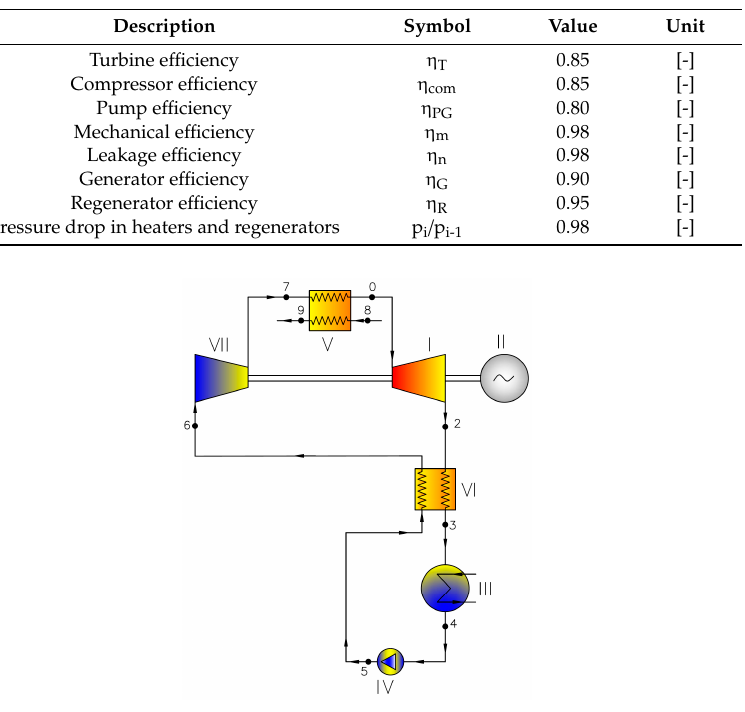
Figure 3. ORC cycle with regenerator and compressor; where: I—turbine, II—generator, III—condenser, IV—pump, V—vapor generator, VI—regenerator, VII—compressor (Variant 5). Energies 2020 , 13 , x FOR PEER REVIEW